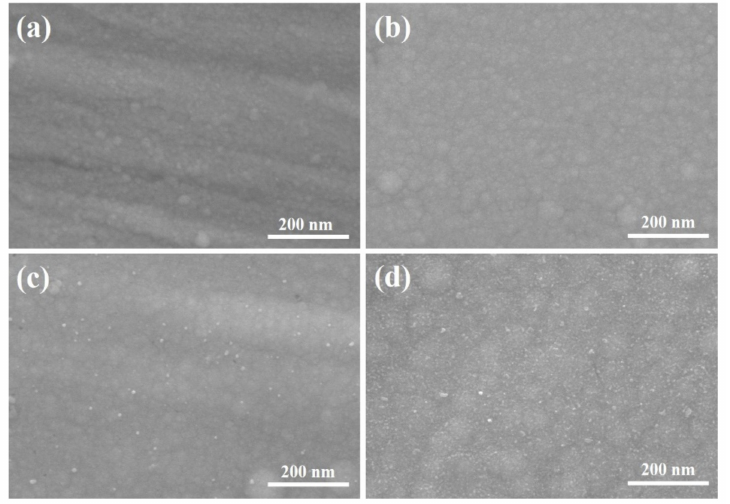
Figure 4. SEM surface micrographs of Ni-Mo-W coatings: ( a ) as-deposited and annealed at ( b ) 200 ◦ C, ( c ) 400 ◦ C and ( d ) 600 ◦